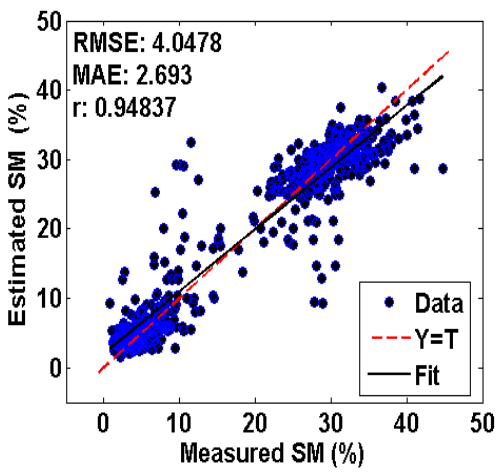
Figure 16. The relationship between measured and estimated SM for combined Datasets 2&3.